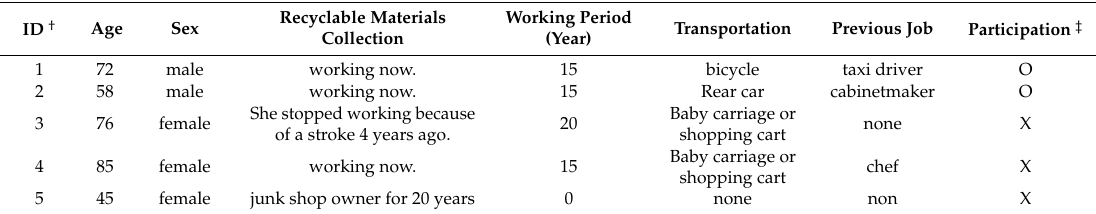
Table 1. General characteristics of study